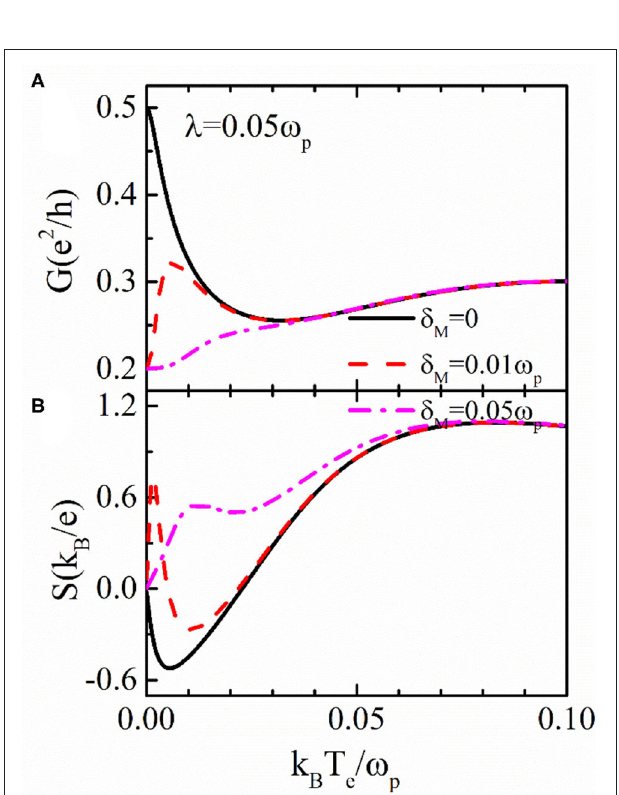
FIGURE 3 | (A) Conductance and (B) thermopower as functions of the temperature T e for ε d 0.2 ω p and different values of the overlap amplitude = − between the MZMs δ M . Other parameters are λ 0.05 ω p and 1 d = =